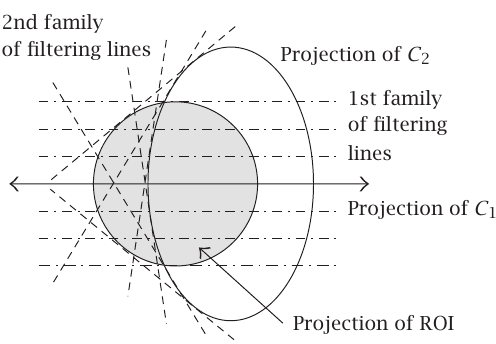
Figure 3.1 . Illustration of filtering lines. The detector plane corre- sponding to y(s) ∈ C 1 is